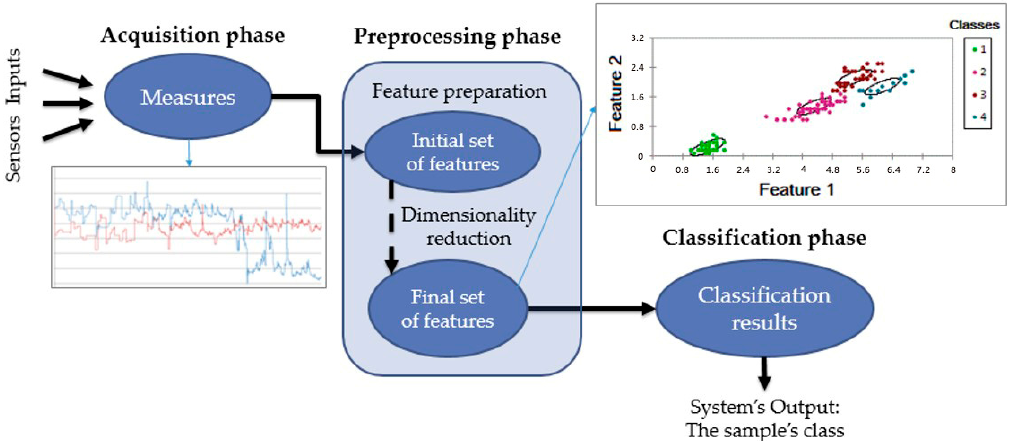
Figure 13. The proposed approach for classifying postures, comprised of three phases: (1) data acquisition; (2) data preprocessing and (3)